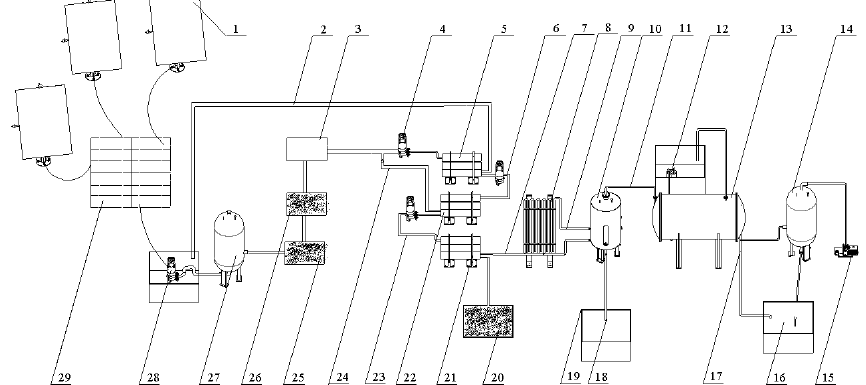
Figure 1. Schematic diagram of the farmland saline–alkali water separation and desalination device: (1) photovoltaic panel; (2) primary reverse osmosis concentrated water outlet; (3) ultrafiltration membrane; (4) variable pressure pump; (5) primary reverse osmosis membrane; (6) primary outlet for water produced through reverse osmosis; (7) tertiary nanofiltration concentrated water outlet; (8) solar cycle collector; (9) concentrated water inlet of the flash tank; (10) flash tank; (11) steam outlet; (12) water circulating pump; (13) shell-and-tube circulating condenser; (14) negative pressure tank; (15) vacuum pump; (16) freshwater tank; (17) fresh water export; (18) salt outlet of the flash tank; (19) salt-drying box; (20) farmland; (21) tertiary nanofiltration membrane; (22) secondary reverse osmosis membrane; (23) secondary outlet for water produced through reverse osmosis; (24) sec- ondary reverse osmosis concentrated water outlet; (25) graphite carbon filter; (26) quartz sand filter; (27) towerless water supply; (28) submersible pump; (29)